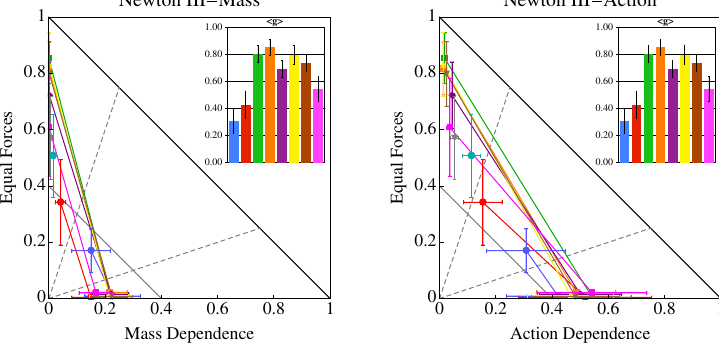
FIG. 7. Model analysis plots of FMCE data from school 2. Normalized gain plots for each cluster are included to allow for easier comparison of representations. Plots for additional question clusters are presented in Appendix